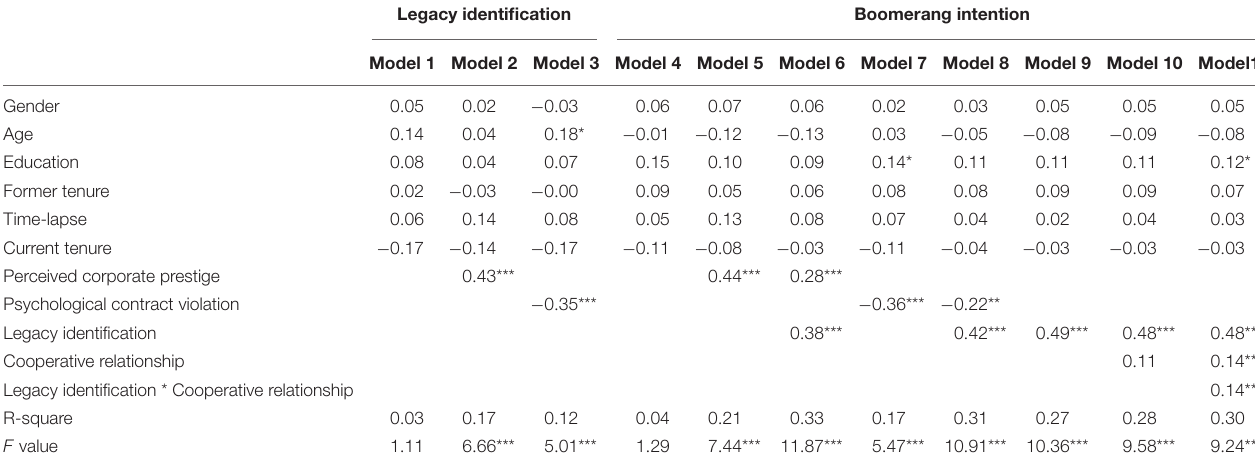
TABLE 3 | Results of multiple regression analysis.